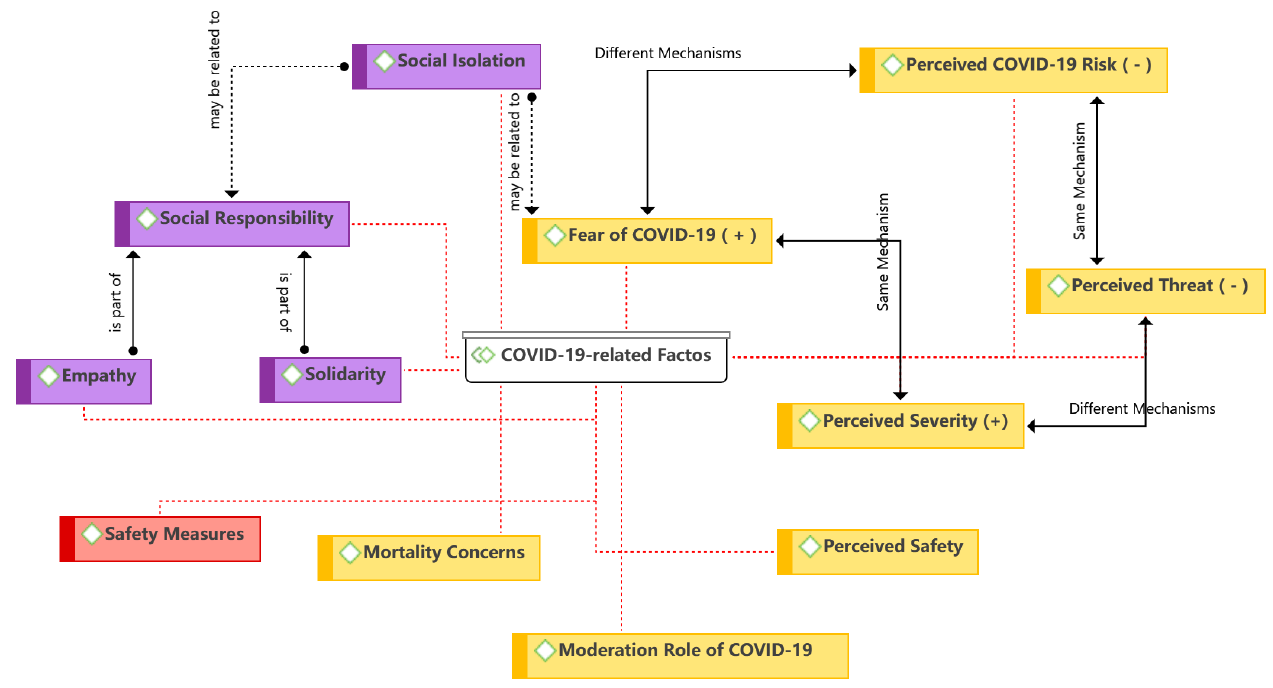
Figure 13. COVID-19-related factors.